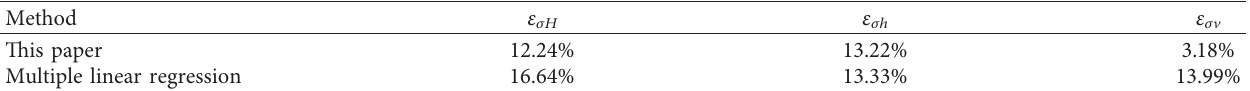
Table 6: The average relative error of two methods.